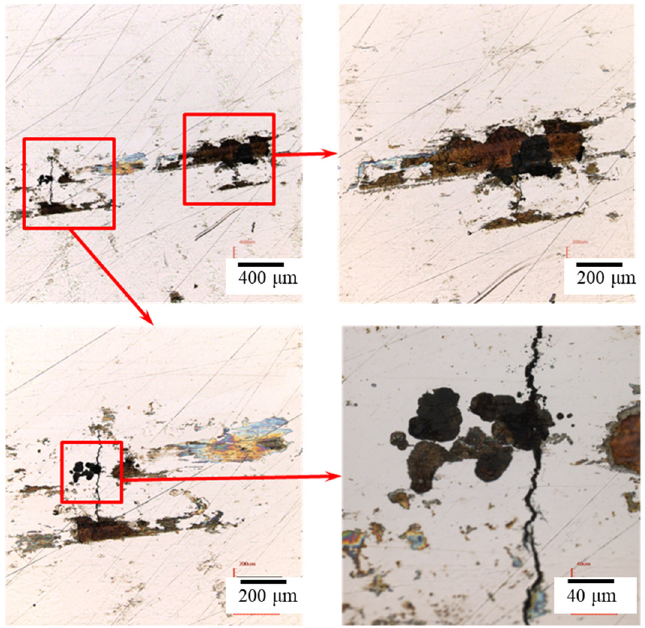
Figure 9. The crevice corrosion specimen with 0.1 g/m 2 of sea salt deposited on the surface subjected to tensile stresses of 300 MPa reveals cracks after 1500 h of testing at 45 °C and a relative humidity of 45%.